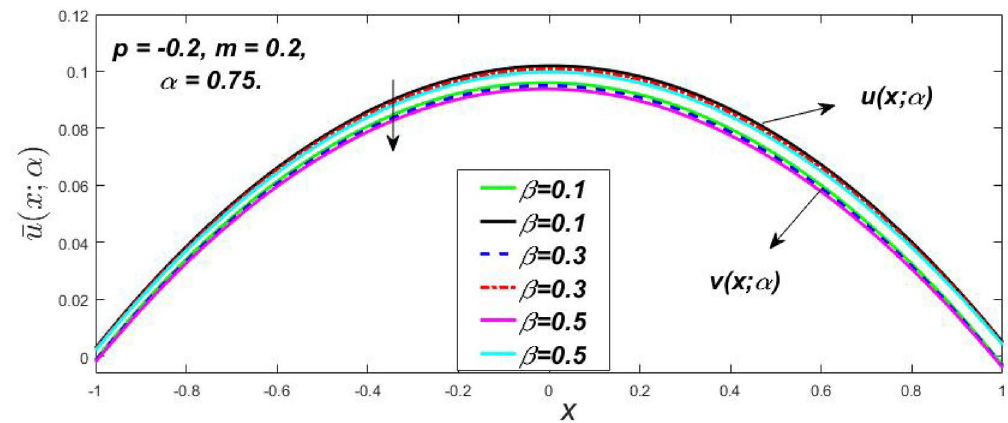
Figure 17. Fuzzy velocity profiles for the impact of β .